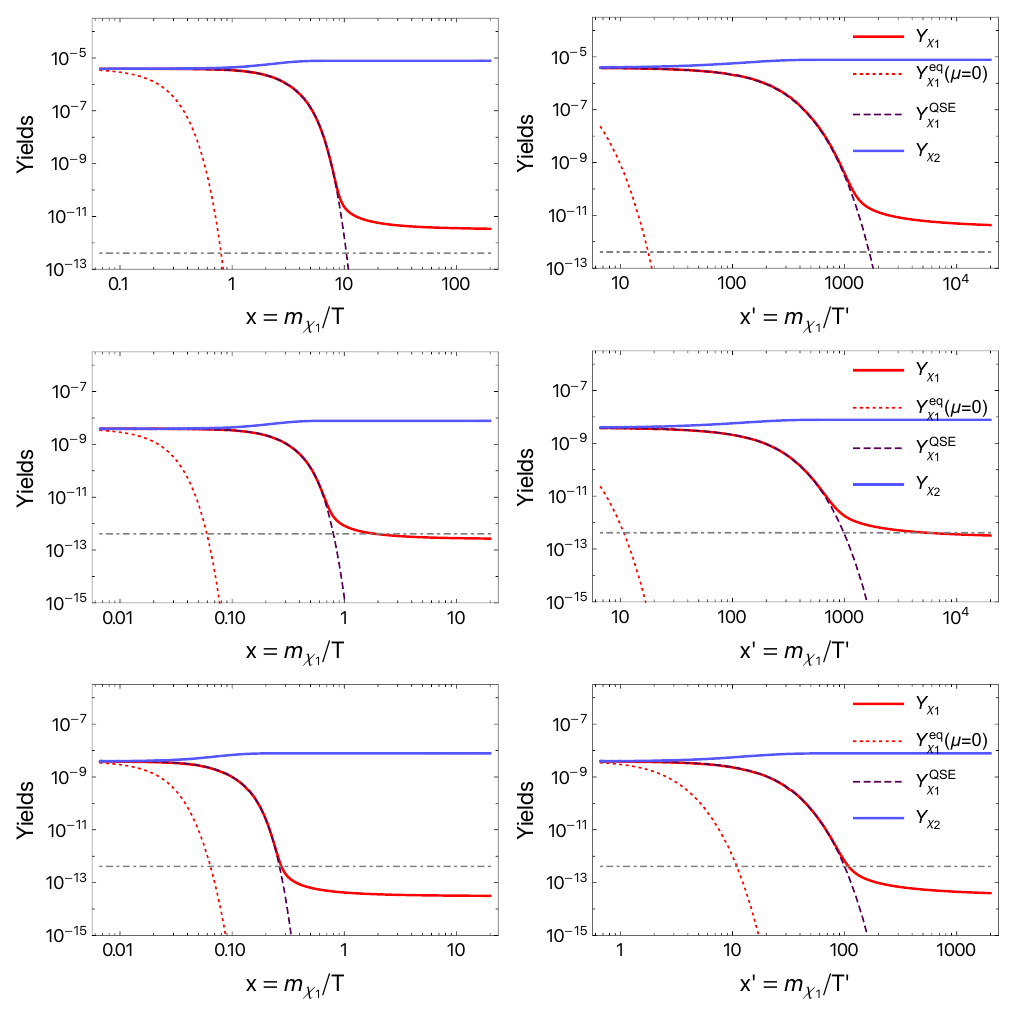
= 1 TeV and g 1 g 2 /m 2 = 1 / (4 TeV ) 2 as A 1